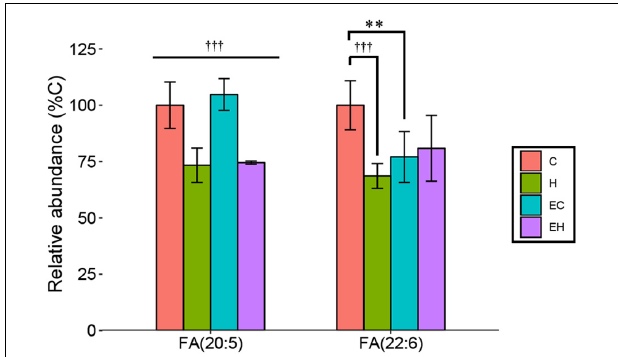
FIGURE 4 | Changes of relative abundance of EPA and DHA in the skeletal muscle with endurance training and/or high-fat diet: ∗∗ p < 0.01 for exercise effect; ††† p < 0.001 for diet effect; straight lines represent the main effect of endurance training or high-fat diet; lines with sticks represent an interaction effect exists between endurance training and high-fat diet. Data are means ±